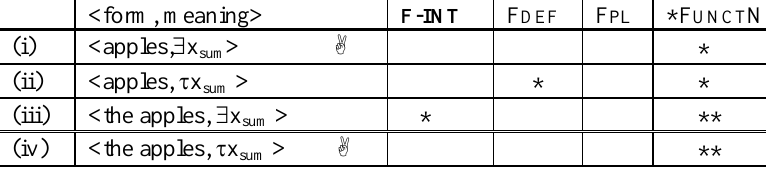
Tableau I: bidirectional OT tableau of the definite/indefinite contrast in